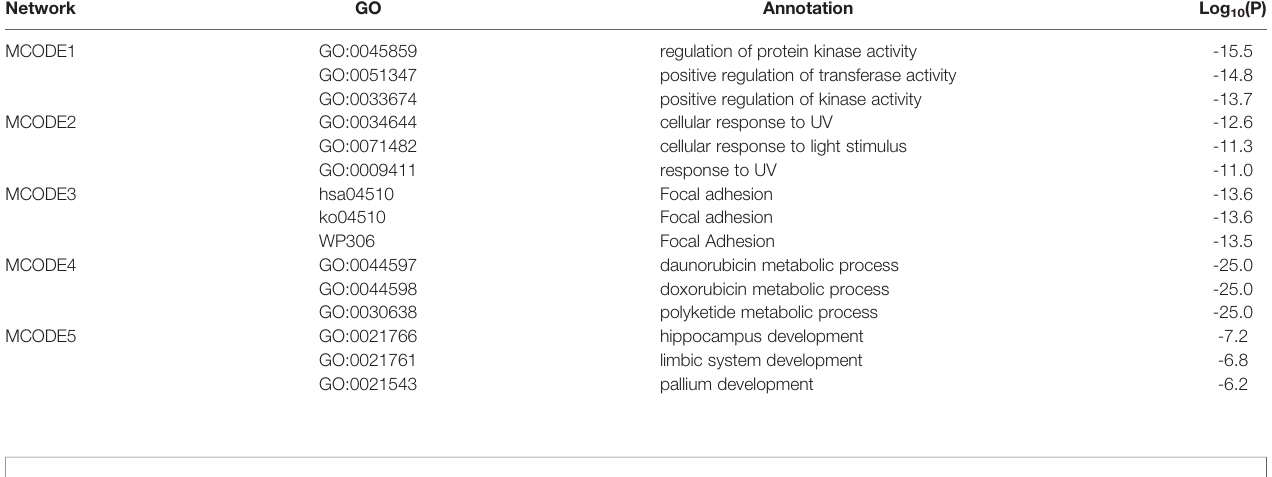
TABLE 6 | Top three enrichment terms of each MCODE components in PPI network.